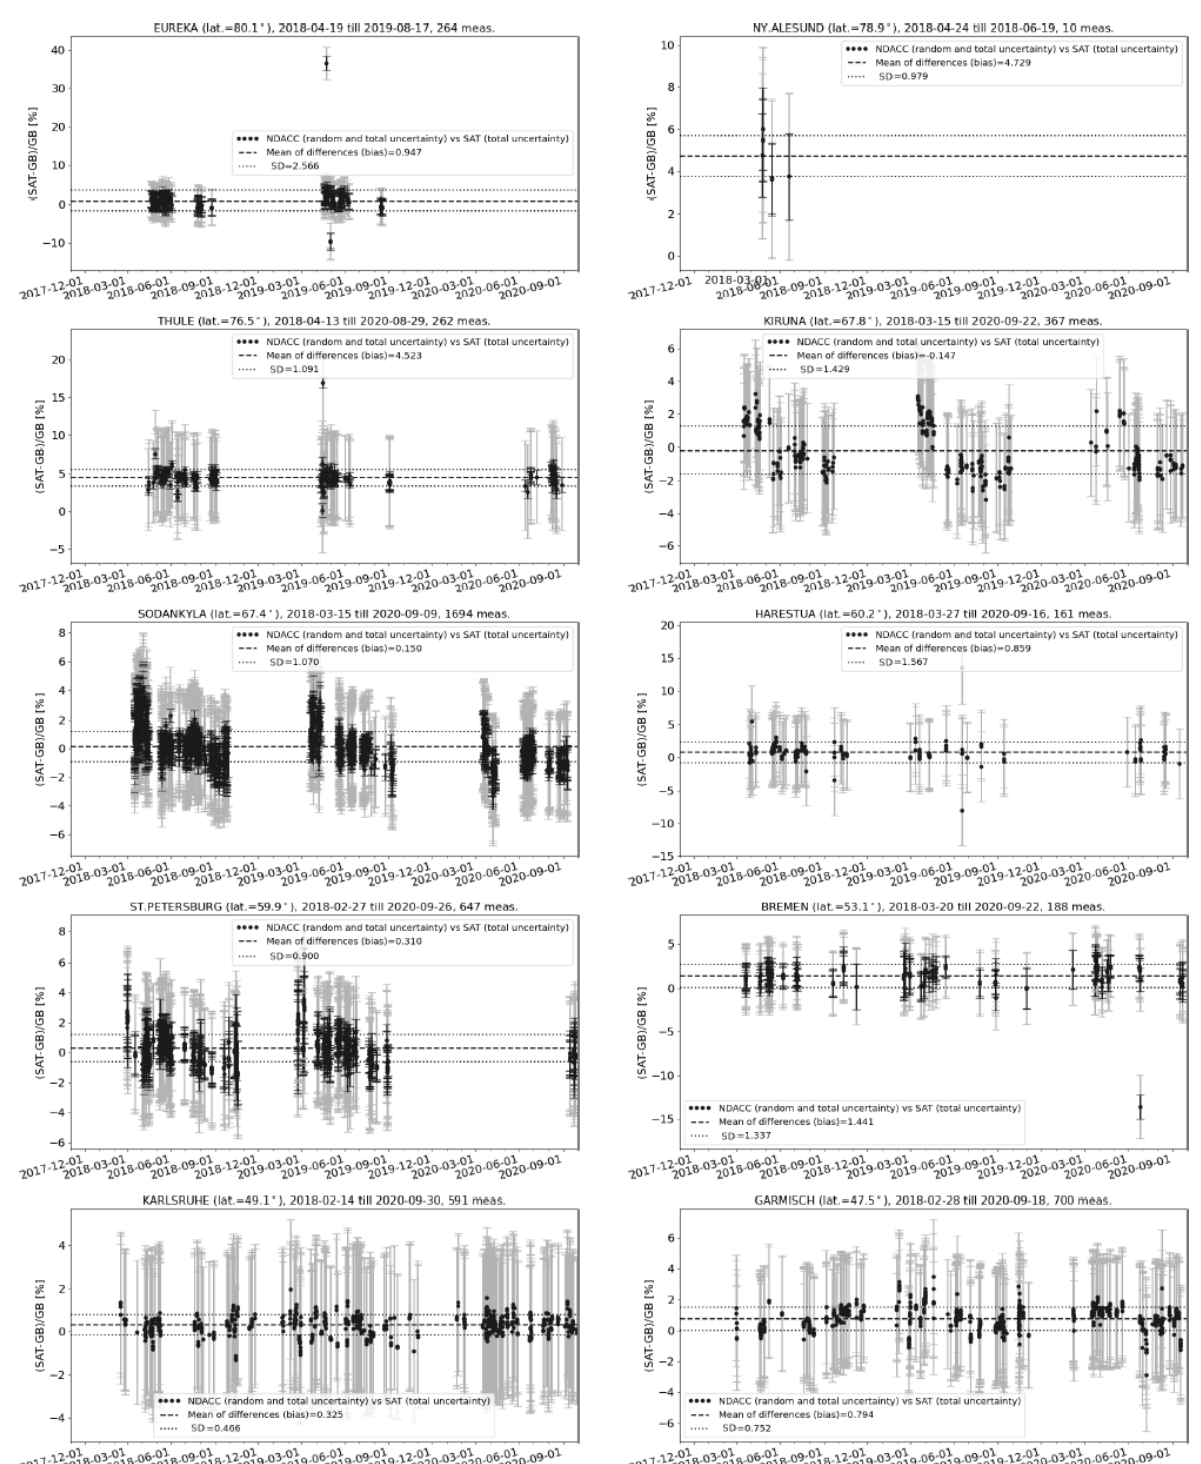
Figure 14. Relative difference ((satellite − ground-based)/ground-based) of XCH 4 time series for all co-located S5P bias-corrected data and NDACC data smoothed with S5P a priori and additionally smoothed with the S5P column-averaging kernel as the reference data at each site ordered with decreasing latitude as in Fig. 12. Spatial co-location with radius of 100km and time of ± 3h around the satellite overpass was